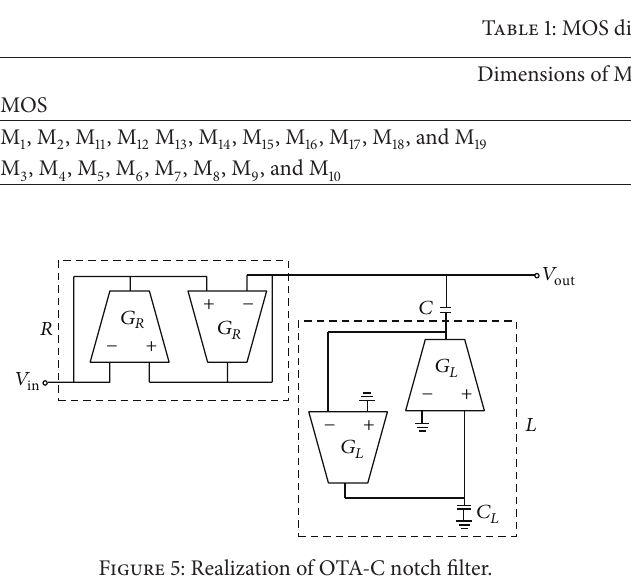
Figure 5: Realization of OTA-C notch